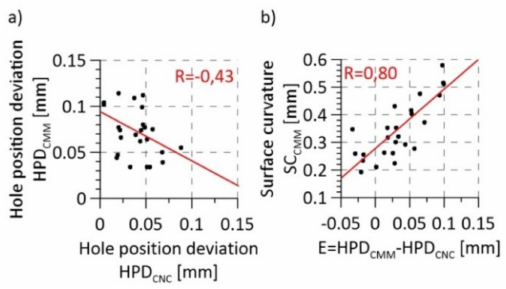
Figure 11. Correlation of measurement data: ( a ) hole position deviation; ( b ) surface